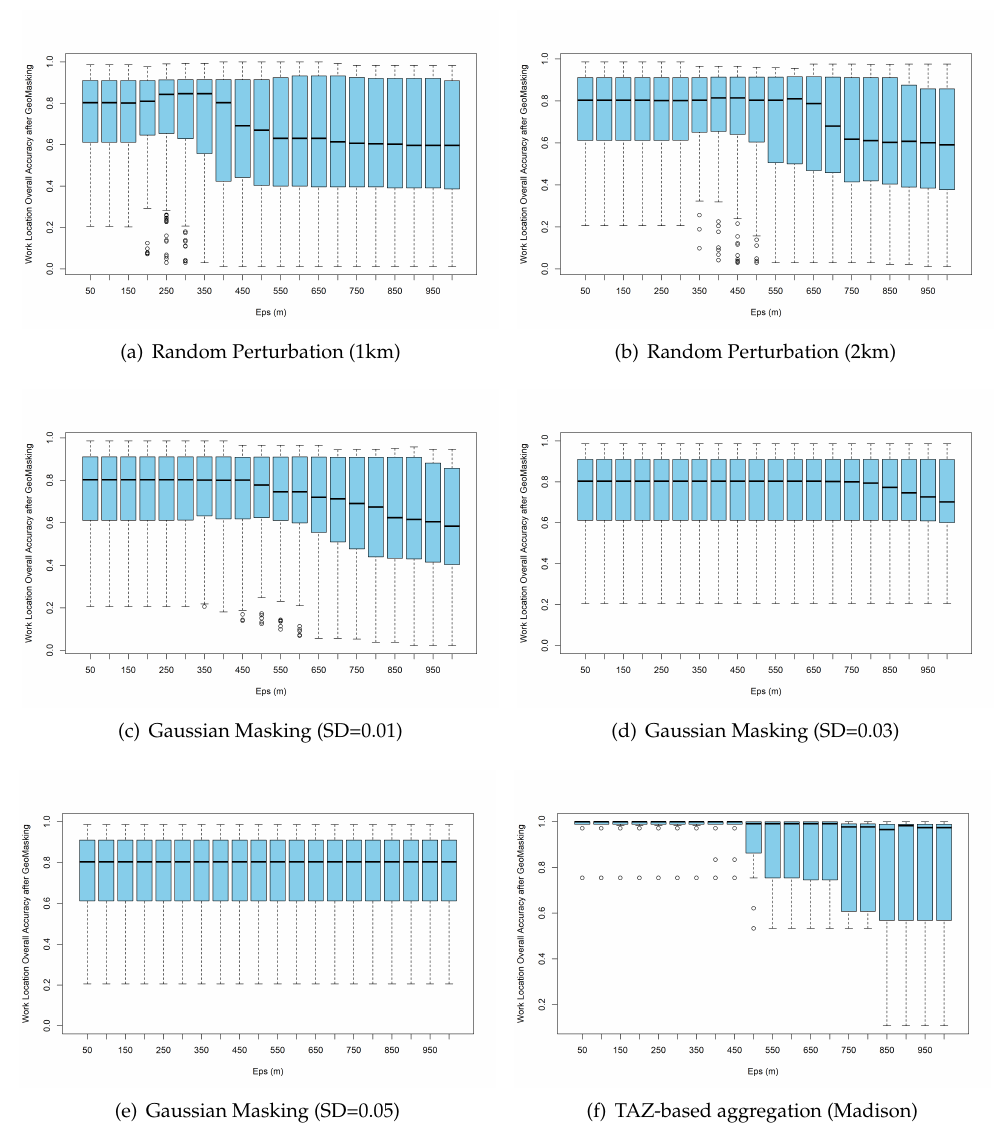
Figure 6: The boxplot of overall accuracy of work cluster detection with different DBSCAN parameters with random perturbation, Gaussian masking, and the TAZ-based aggregation. As for the Gaussian perturbation, we found that it is effective for protecting users’ home locations with proper parameters. The mean of overall accuracy for identifying users’ home clusters using two-dimensional Gaussian kernels with 0.05 standard deviation (SD) is less